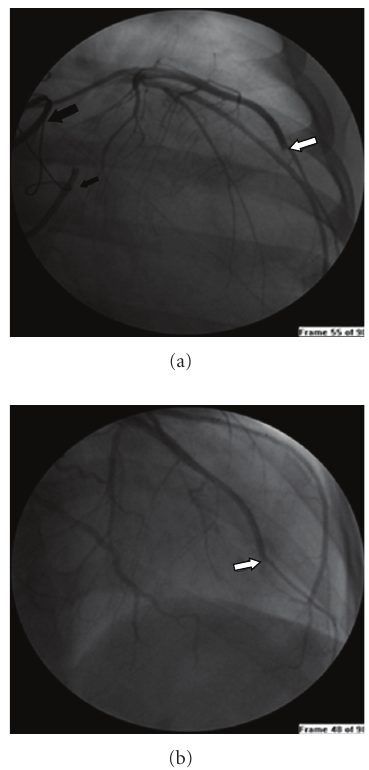
Figure 3: Coronary angiograms showing distal occlusion of the left anterior descending coronary artery with a concave endoluminal image strongly suggesting embolic material in two di ff erent projec- tions (white arrows), mechanical aortic valve prosthesis (large black arrow) and mitral valve repair (small black